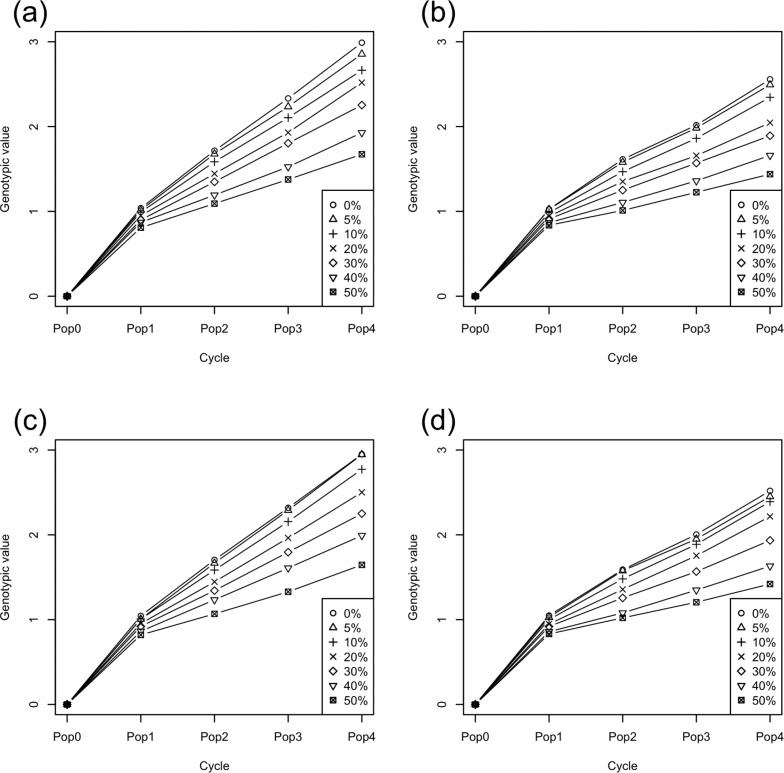
Genetic gain through four cycles of selection: (a) source errors and seedling scheme, (b) source errors and no-seedling scheme, (c) substitution errors and seedling scheme, (d) substitution errors and no-seedling scheme. Symbols indicate the mislabeling rate. Pop, population.